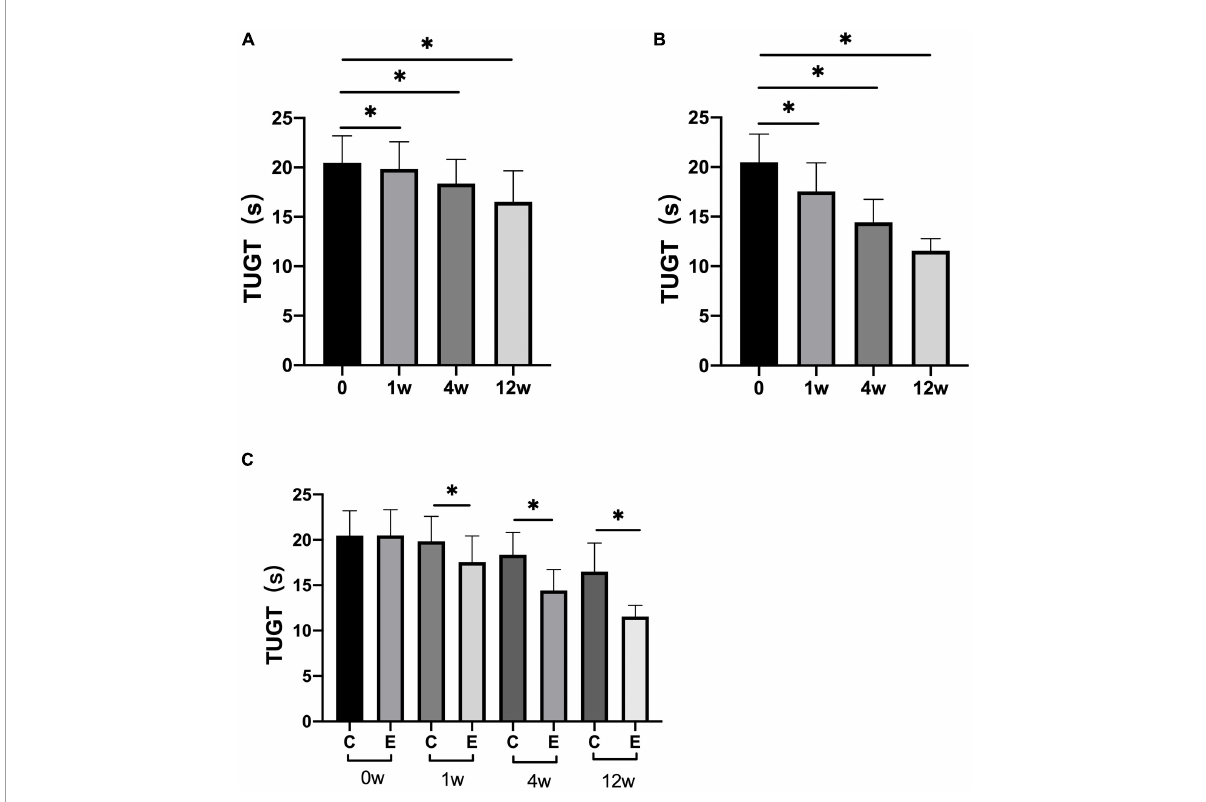
FIGURE4 Changes in timed “Up and Go” tests (TUGTs). (A) TUGT at 1, 4, and 12 weeks compared with that at 0 week in control group; (B) TUGT at 1, 4, and 12 weeks compared with that at 0 week in experimental group; (C) TUGT at 0, 1, 4, and 12 weeks in experimental group compared with control group; ∗ p <